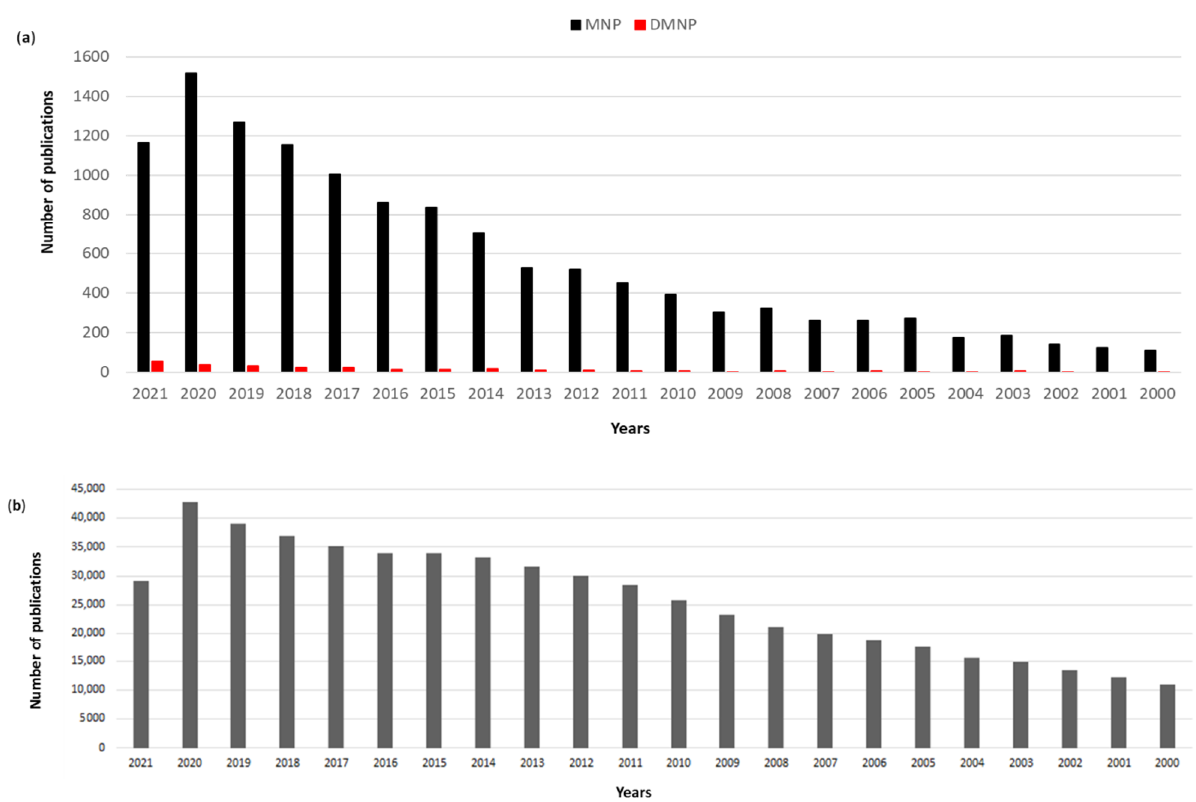
Figure 1. PubMed search results 2000–2021 by using as filters ( a ) the words “marine” and “natural products” for marine natural products (MNP) and “deep”, “marine” and “natural products” in “all fields” for deep marine natural products (DMNP), respectively, ( b ) the words “natural products” in “all fields”.